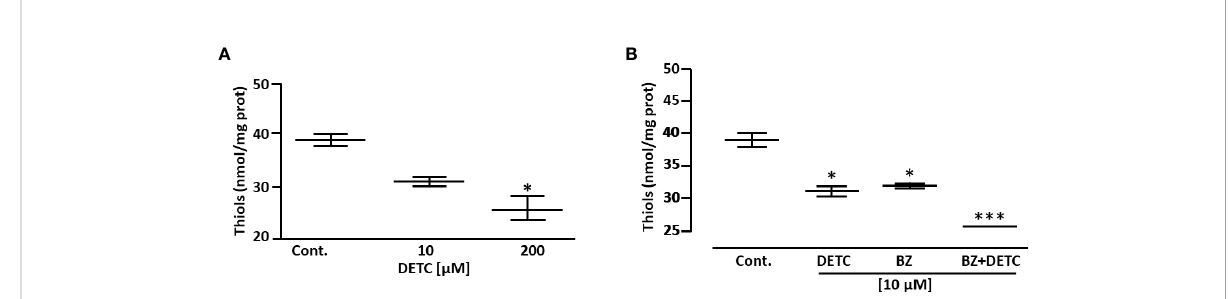
FIGURE 8 Effect of DETC and BZ on the concentration of low mol. wt. thiols of T. cruzi epimastigote forms (Y strain), determined colorimetrically by the Ellman reaction. DETC reduced thiol levels dose-dependently (A) . The DETC + BZ combination signi fi cantly potentiated thiol depletion (B) . Data represent mean ± SD. * p < 0.05 and *** p < 0.001 (ANOVA and Dunn ’ s post-test; n = 5).